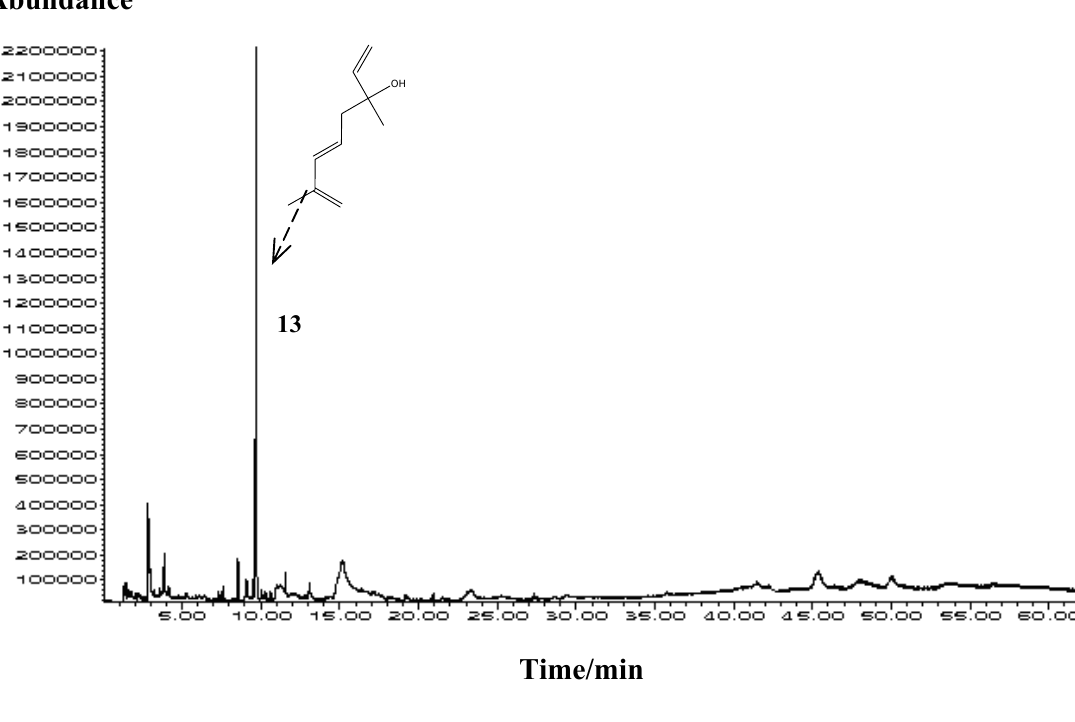
Figure 3. Representative TIC chromatogram of solvent-free extractives of Mentha spp. honey obtained by